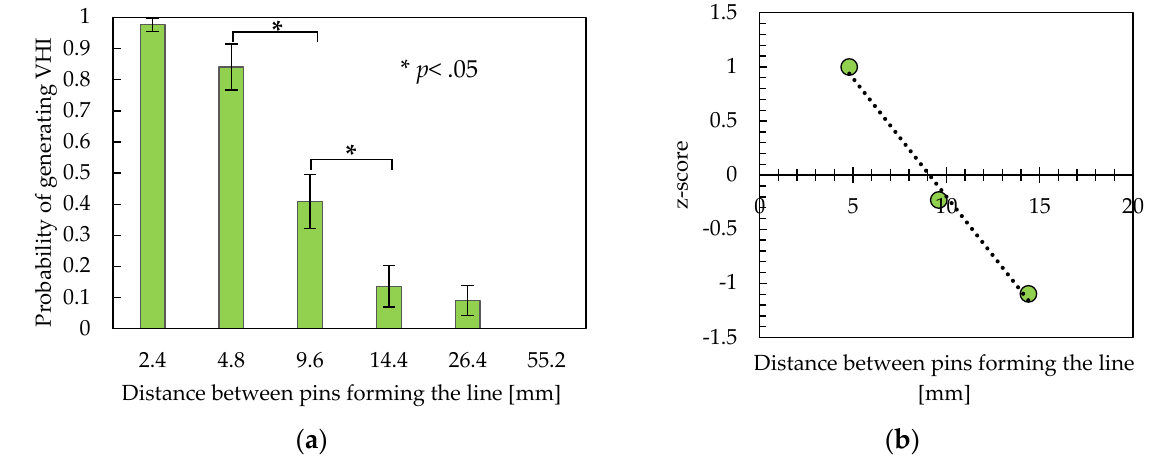
Figure 7. Relationship between pin distances when forming line and probability of generating VHI: ( a ) probability of generating VHI and ( b ) z-score.